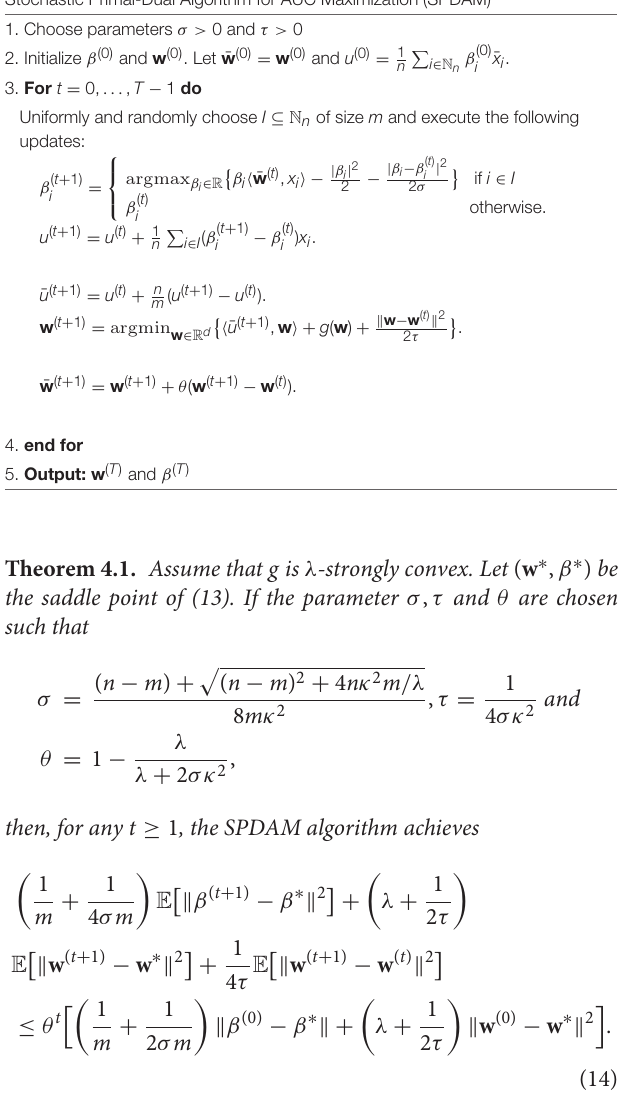
TABLE 1 | Pseudo-code of Stochastic Primal-Dual Algorithm for AUC maximization. Stochastic Primal-Dual Algorithm for AUC Maximization